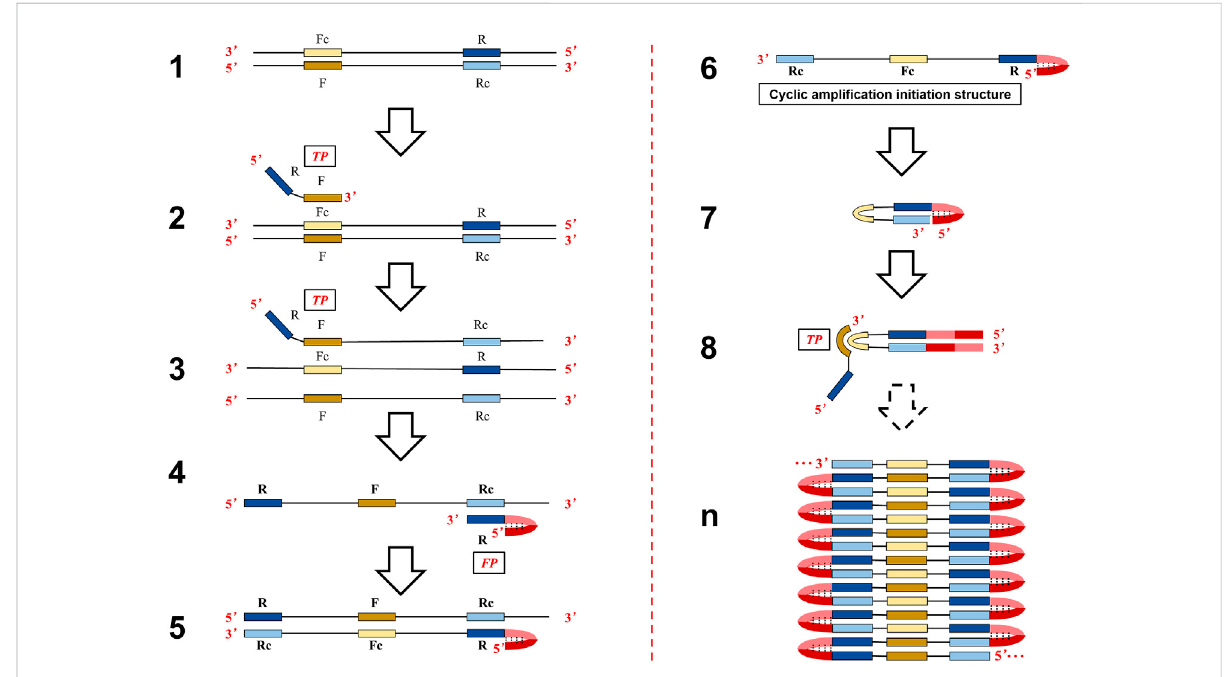
FIGURE 1 Schematic presentation of the mechanism of the ASLAMP